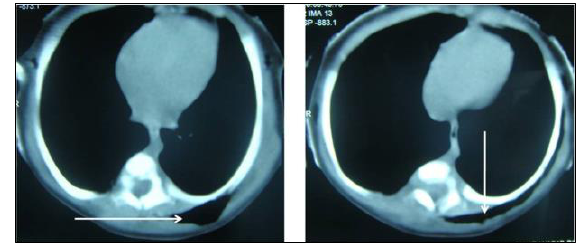
Figure 2: CT scan of the chest showing subcutaneous em- physema (arrows) in the left lower posterior thoracic